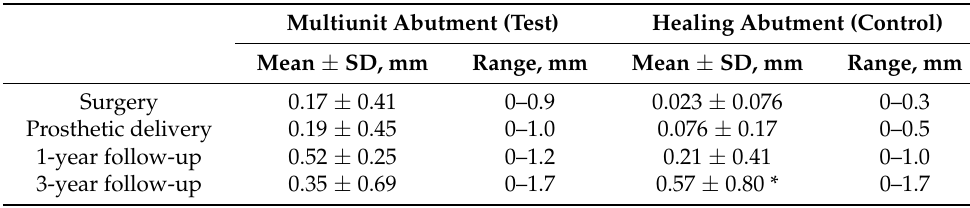
Table 4. Differences (in mm) at the crestal bone level at surgery, prosthetic delivery, and 1-year and 3-year follow-up of the multiunit (test) and healing abutments